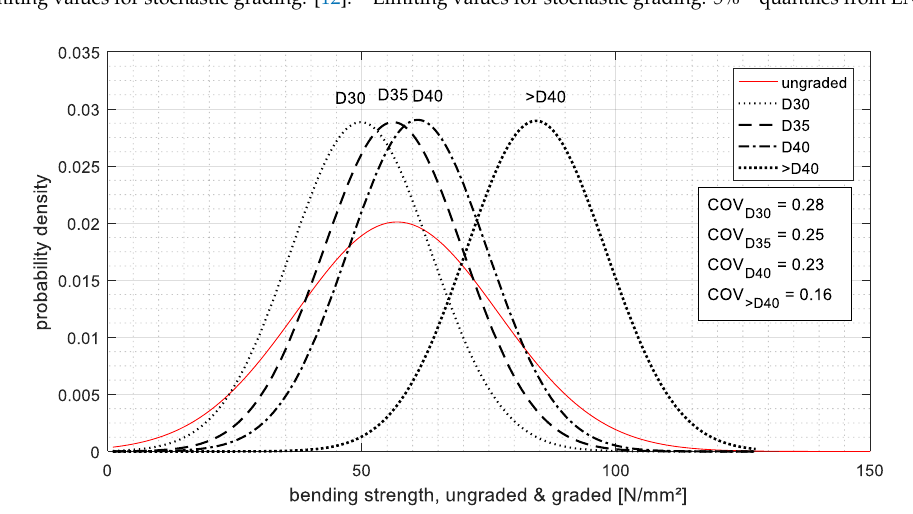
Figure 3. Probability density functions of graded and ungraded materials from the stochastic grading model for oak samples and strength grading based on an indirect ultrasonic-time-of-flight measurement.